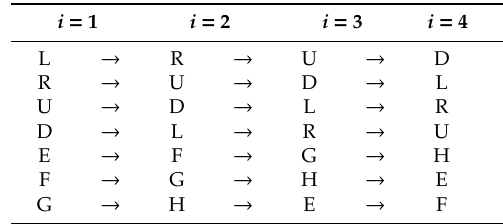
Table 1. Replacement of the